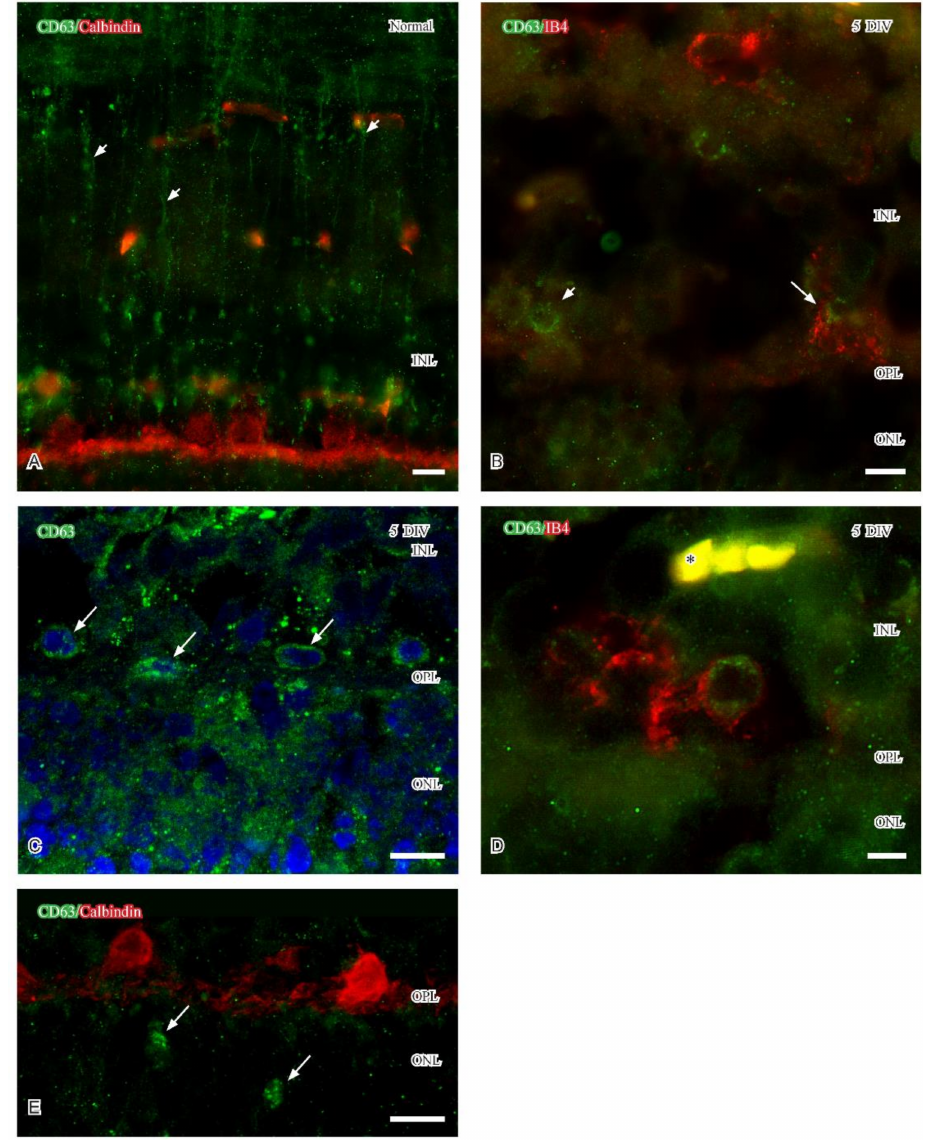
Figure 3. Confocal stacks ( C ) and fluorescence micrographs ( A , B , D ) showing CD63 immunoreactivity (green) in normal and 5 DIV retina. Calbindin immunoreactivity and IB 4 labeling (red) indicate horizontal and microglial cells, respectively. ( A ) Dotted CD63 immunoreactivity is evident in Müller cells in healthy retina. ( B ) IB 4 -labeled microglia close to the OPL with perinuclear CD63 immunoreac- tivity (large arrow). Note the presence of CD immunoreactive cell without IB 4 labeling (small arrow). ( C , D ) High magnification of the OPL showing perinuclear CD63 immunoreactivity (arrows in C ) and in IB 4 -labeled microglia ( D ). Note also labeled capillary (asterisk in ( D )). ( E ) CD63 vesicular immunoreactivity in presumptive microglia (arrows) in ONL. Abbreviations as in Figure 1. Scale ( A – E ) 10 µ